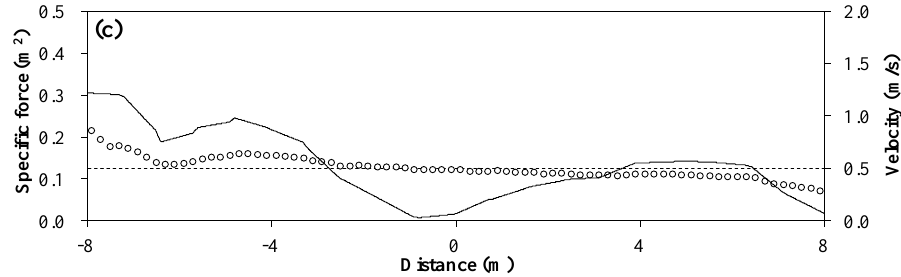
Figure 13. Changes of the specific force and the velocity in Sec. A: ( a ) Case P1Q1; ( b ) Case P123Q1; ( c ) Case P1234Q1.